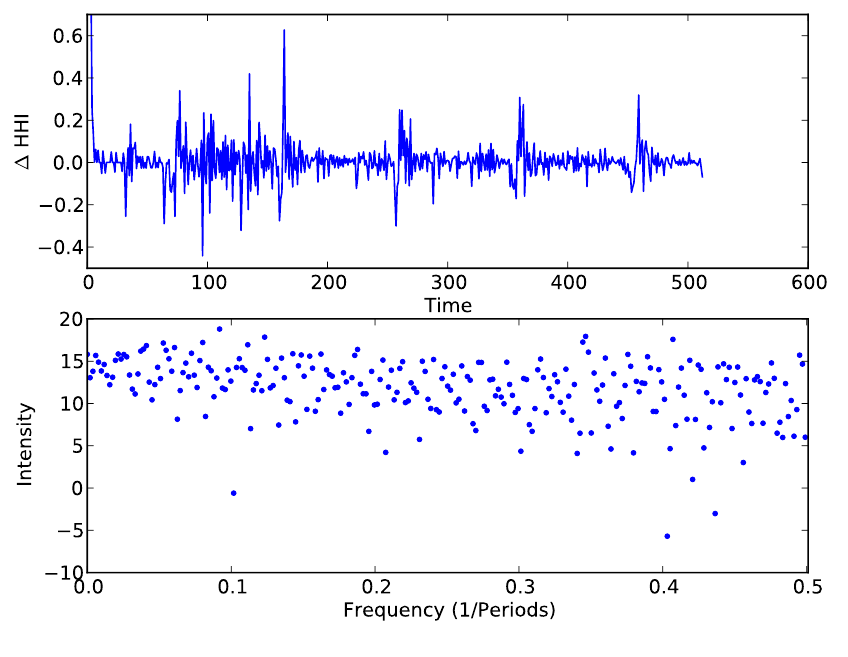
Figure 13. Development of the growth (rates) of the Herfindahl-Hirschman Index and the frequency spectrum of that time series for ↵ = 2 . 0 ).